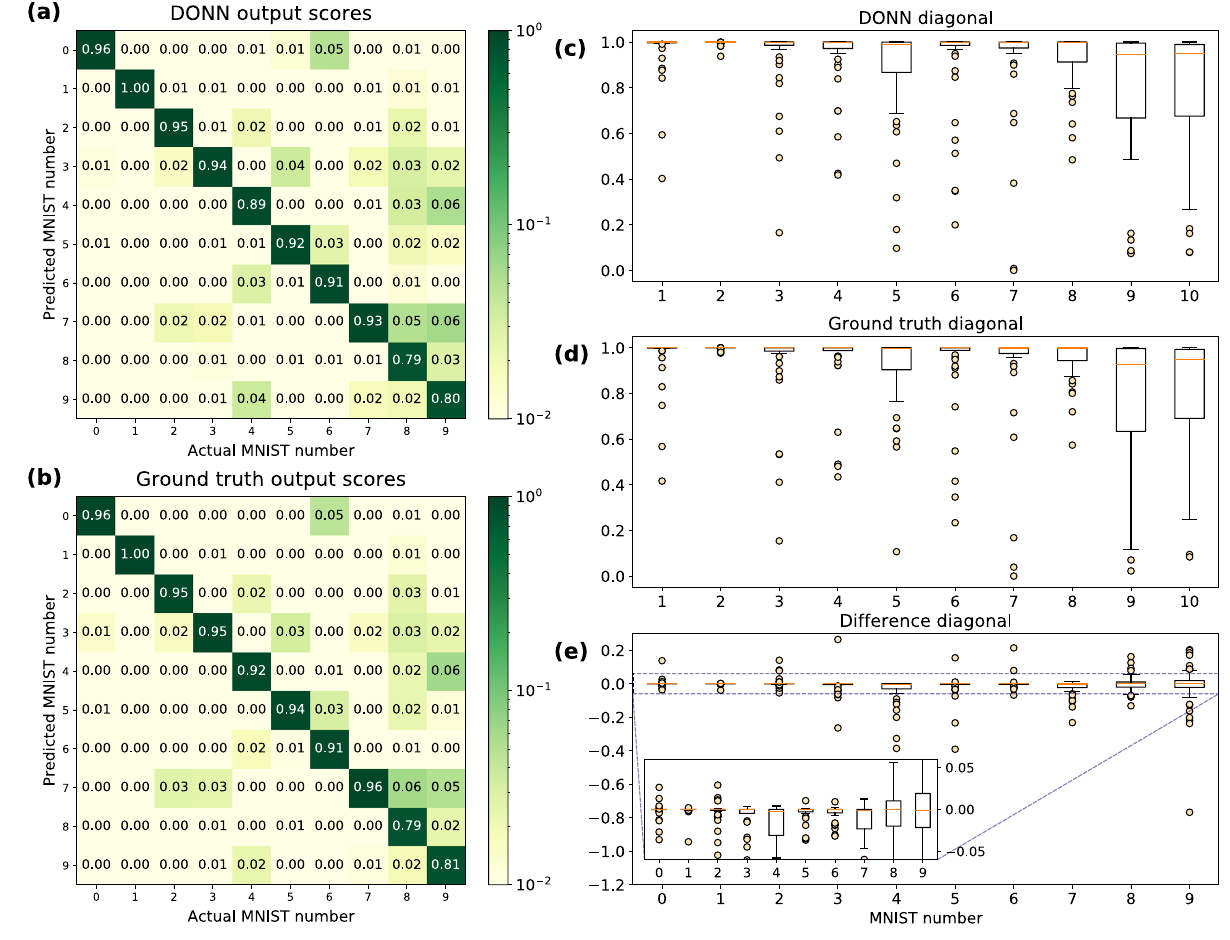
Figure 5. Experimentally measured 3-layer FC-NN output scores, otherwise known as confusion matrix, for 500 MNIST images from test dataset. The values along the diagonal represent correct classification by the model. Each column is an average of ∼ 50 vectors. ( a ) DONN output scores (no crosstalk correction applied). ( b ) Ground-truth (all-electronic) output scores. ( c , d ) Box plot of the diagonals of subfigures ( a ) and ( b ) respectively. ( e ) Difference in diagonals of DONN output scores versus ground-truth output scores. Box plots represent the median (orange), interquartile range (IQR, box) and ‘whiskers’ extending 1.5 IQRs beyond the first and third quartile; outliers are displayed as yellow circles.